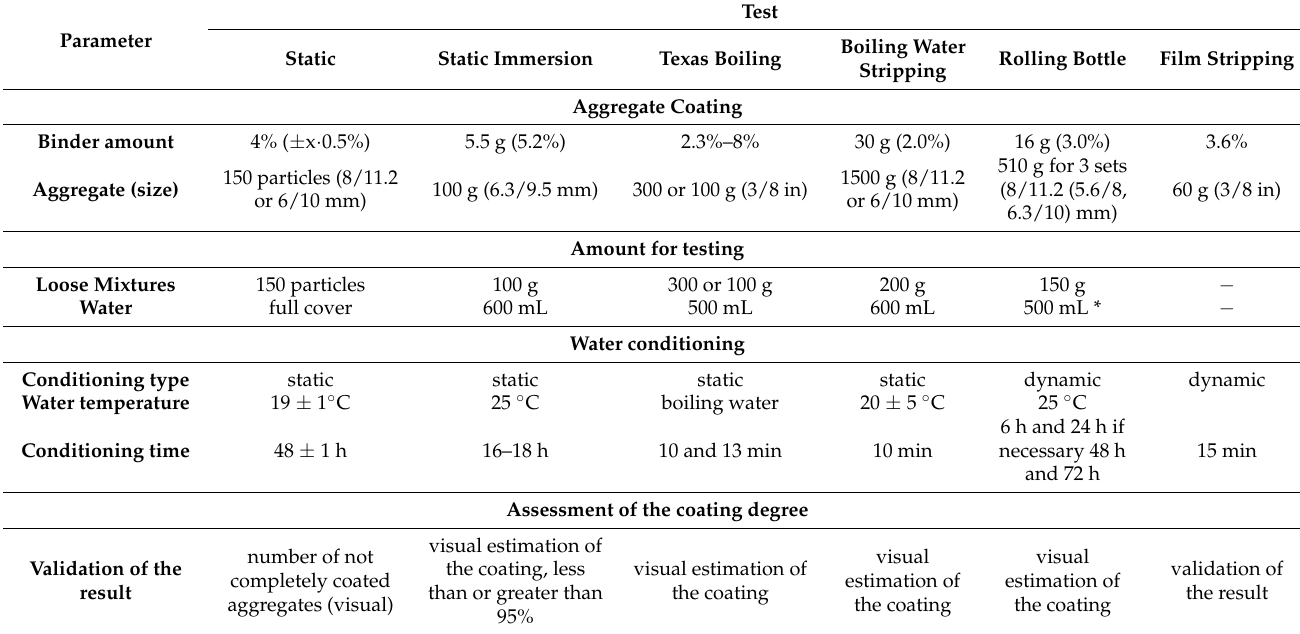
Table 2. Conditions of the most common methods that use Loose Mixtures treated with